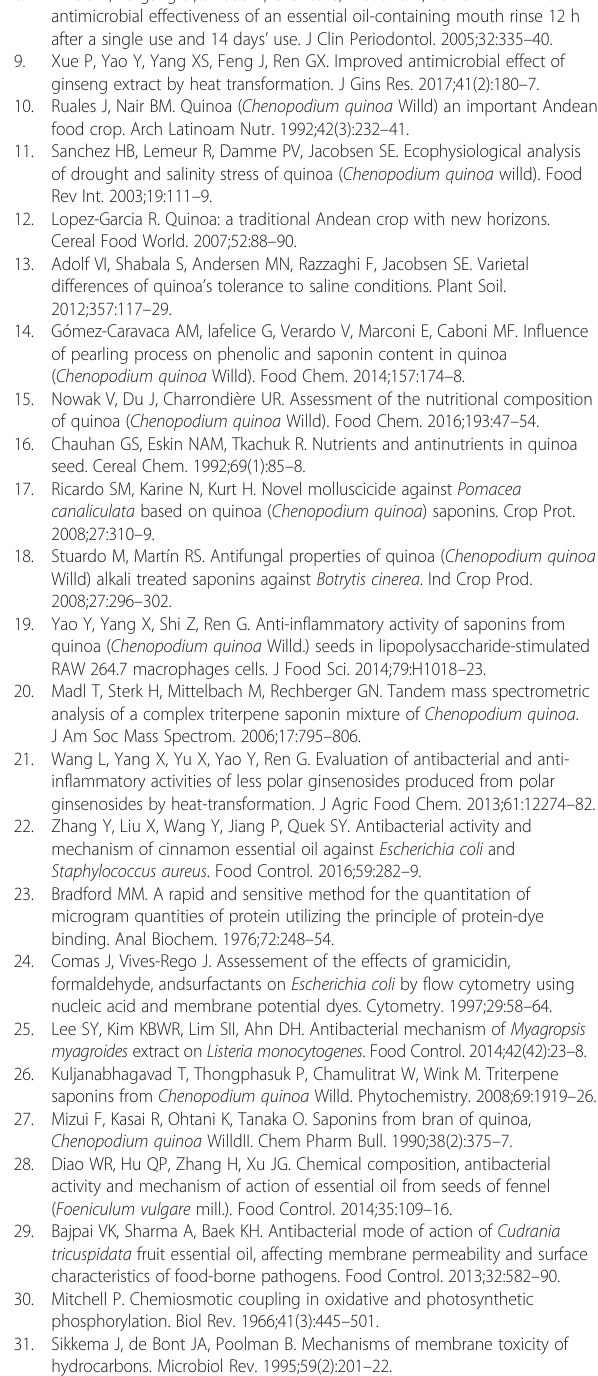
Abbreviations AQS: Alkali-transformed Quinoa Saponin; Ara: α -L-arabinopyranosyl;